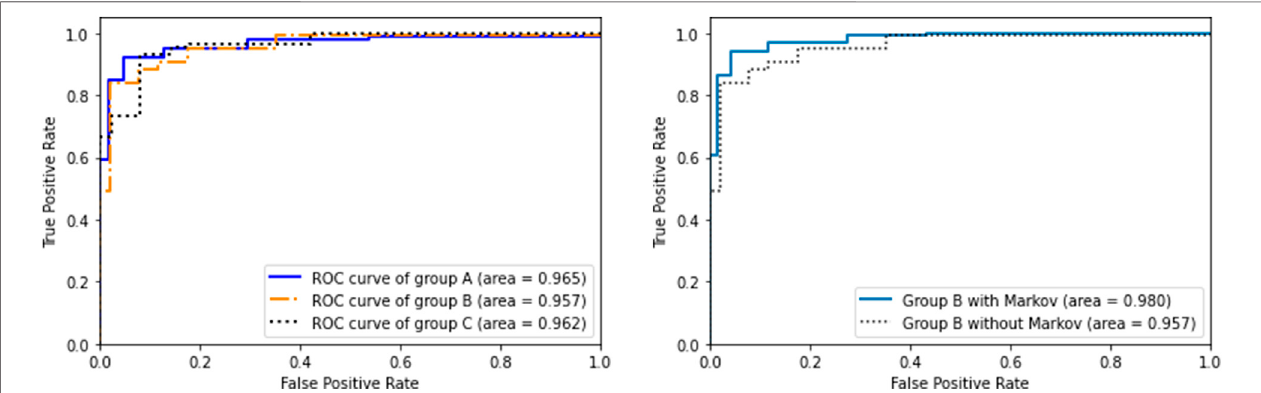
FIGURE 10 | ROC curves of different experiment conditions on spider-inspired HCCapture.